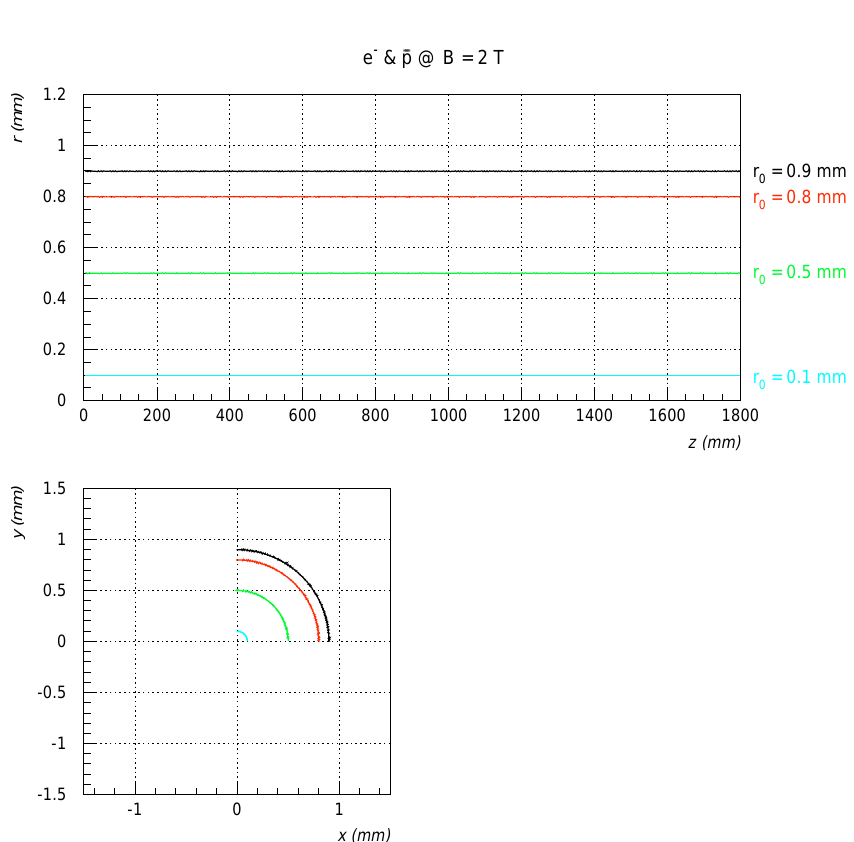
FIG. 2. (Color) Electron beam behavior inside (cid:197) (cid:112) bunch at 2 T.